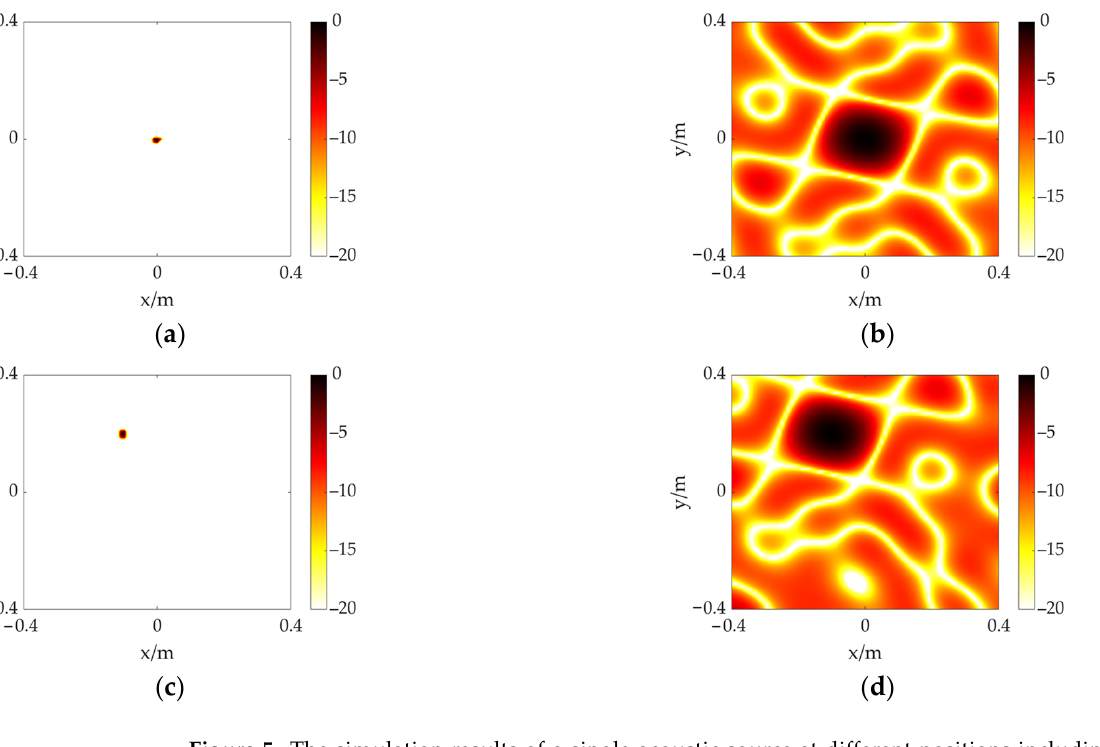
Figure 5. The simulation results of a single acoustic source at different positions including (0, 0) and ( − 0.10, 0.20). Distance is 2 m. ( a ) FFT-FISTA, (0, 0); ( b ) CSIF, (0, 0); ( c ) FFT-FISTA, ( − 0.10, 0.20); ( d ) CSIF, ( − 0.10, 0.20).